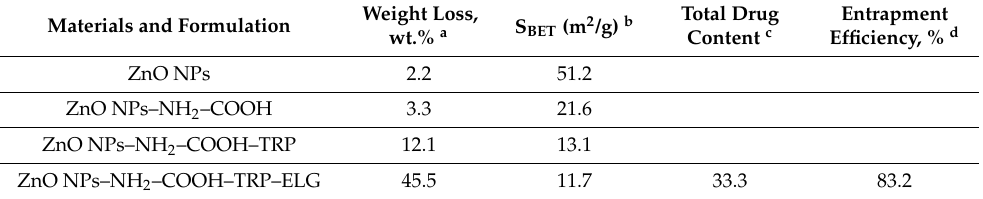
Table 1. Physicochemical characteristics and drug loading properties of the prepared materials and nanoformulations.